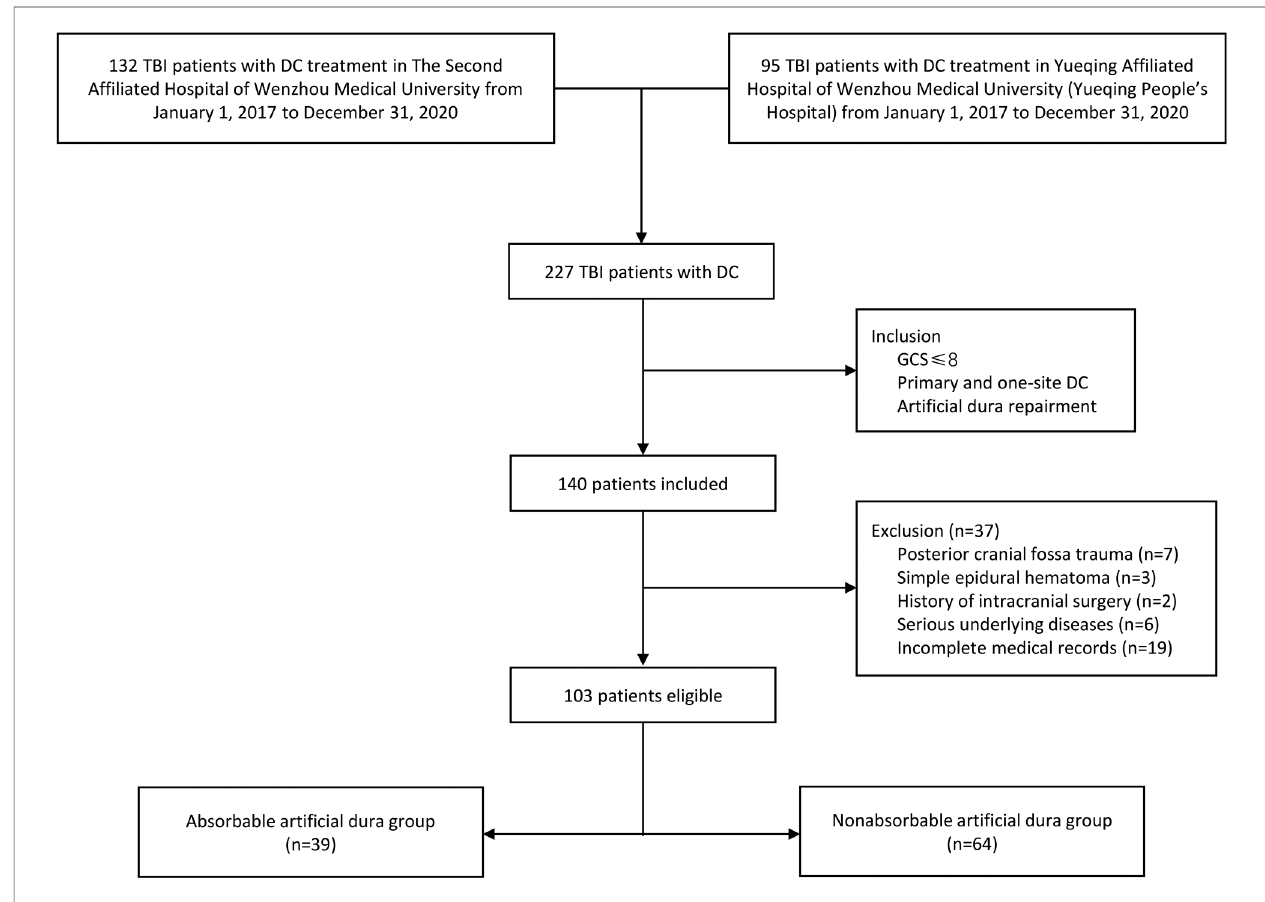
FIGURE 1 | Flowchart of